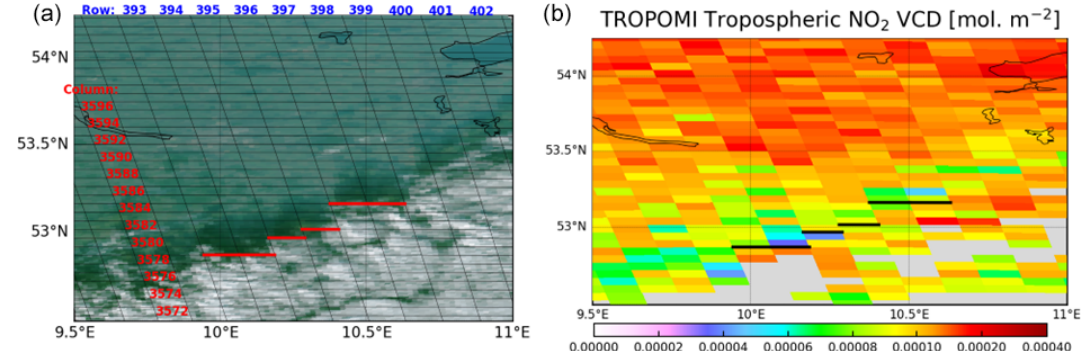
Figure 18. Example of satellite observation for the cloud shadow band on 30 December 2019. (a) The VIIRS RGB image with TROPOMI footprint. (b) The TROPOMI tropospheric NO 2 VCDs; the grey regions represent pixels with CF w > 50%. The red (left) and black (right) lines indicate the cloud edge in the along-track direction from row 393 to 398.